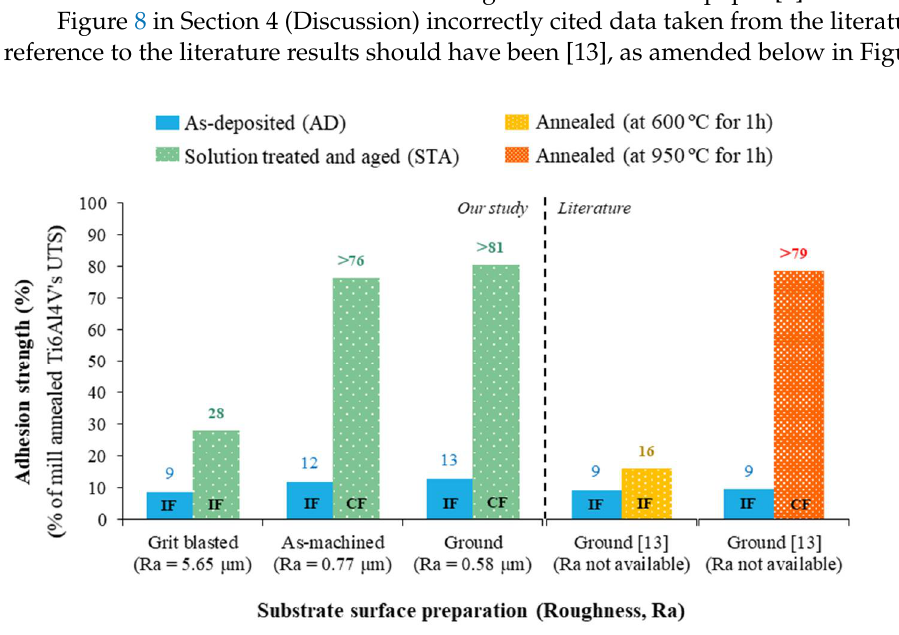
Figure 8. Adhesion strength in terms of % of mill-annealed Ti6Al4V’s ultimate tensile strength (UTS), before and after thermal treatments, and comparison with the literature. (Note: IF—interface failure; CF—cohesion failure.)